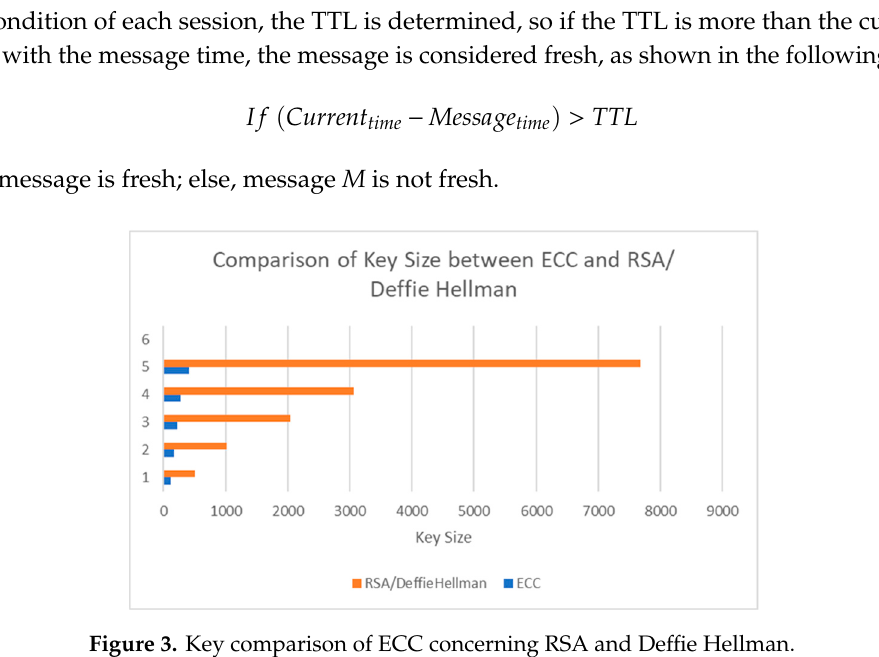
Figure 3. Key comparison of ECC concerning RSA and Deffie Hellman.